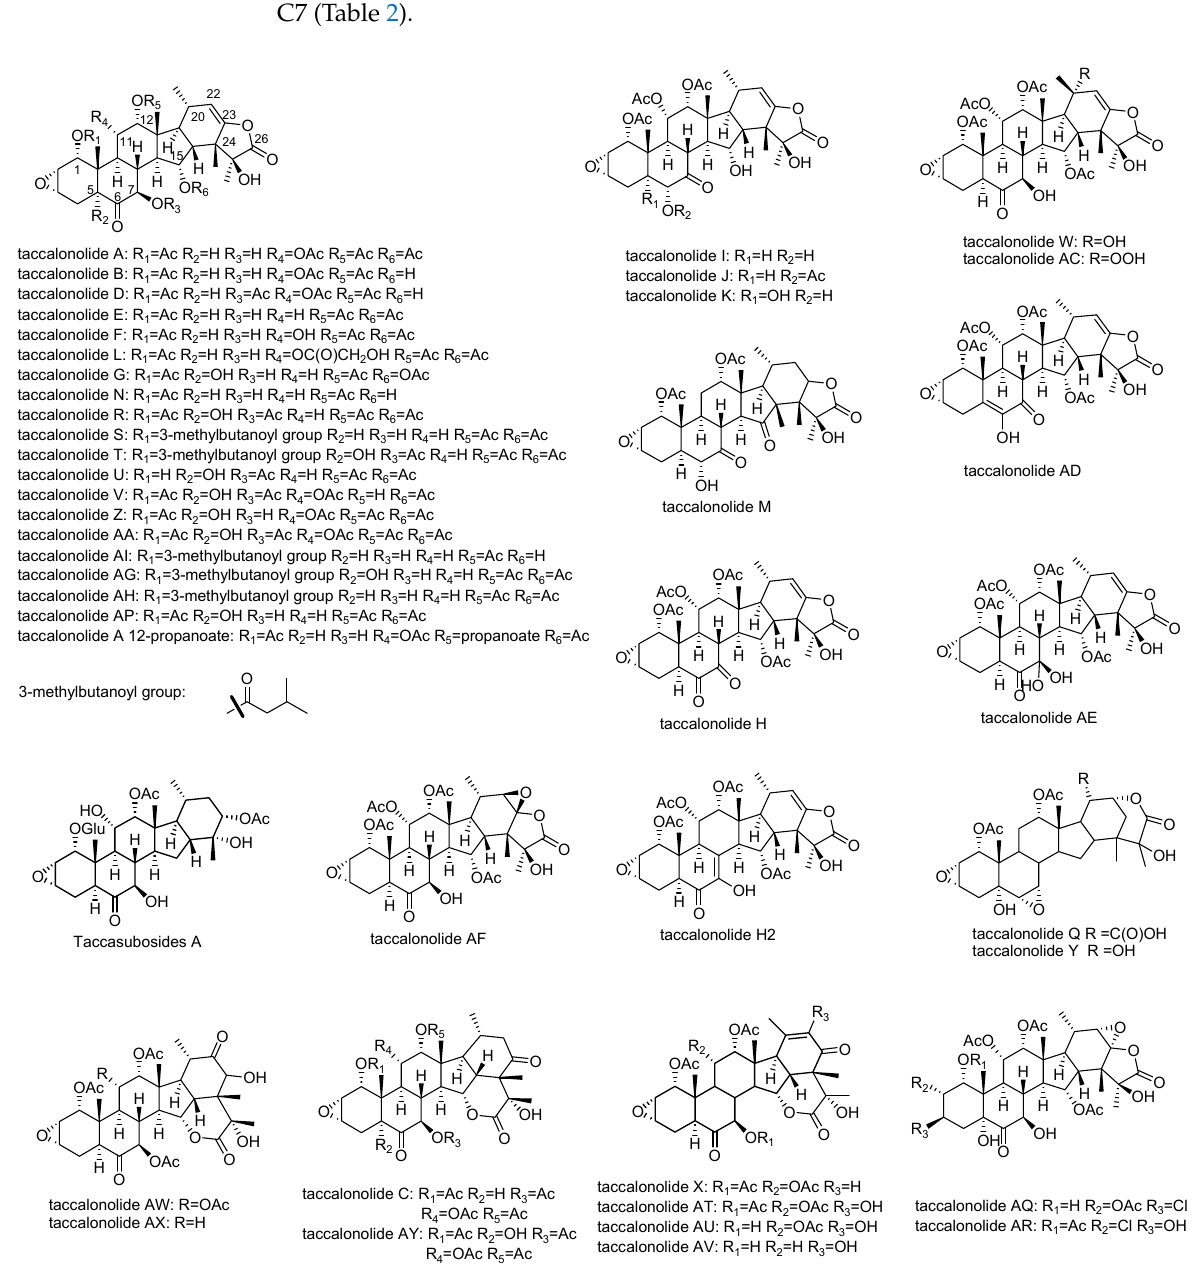
age of the enol- γ -lactone ring and the formation of δ -lactone between C15 and C24 or C22 and C24, which is seen in taccalonolides C, X, Q, and Y. Additionally, taccalonolide H 2 and Taccalonolide AD have an uncommon unsaturated ring B with a double bond at C5,6 and C7,8, respectively (Figure 2). Taccalonolides I, J, and K are distinguished from other taccalonolides by the shift of the ketone group on ring B that is typically located at C6 to C7 (Table 2).